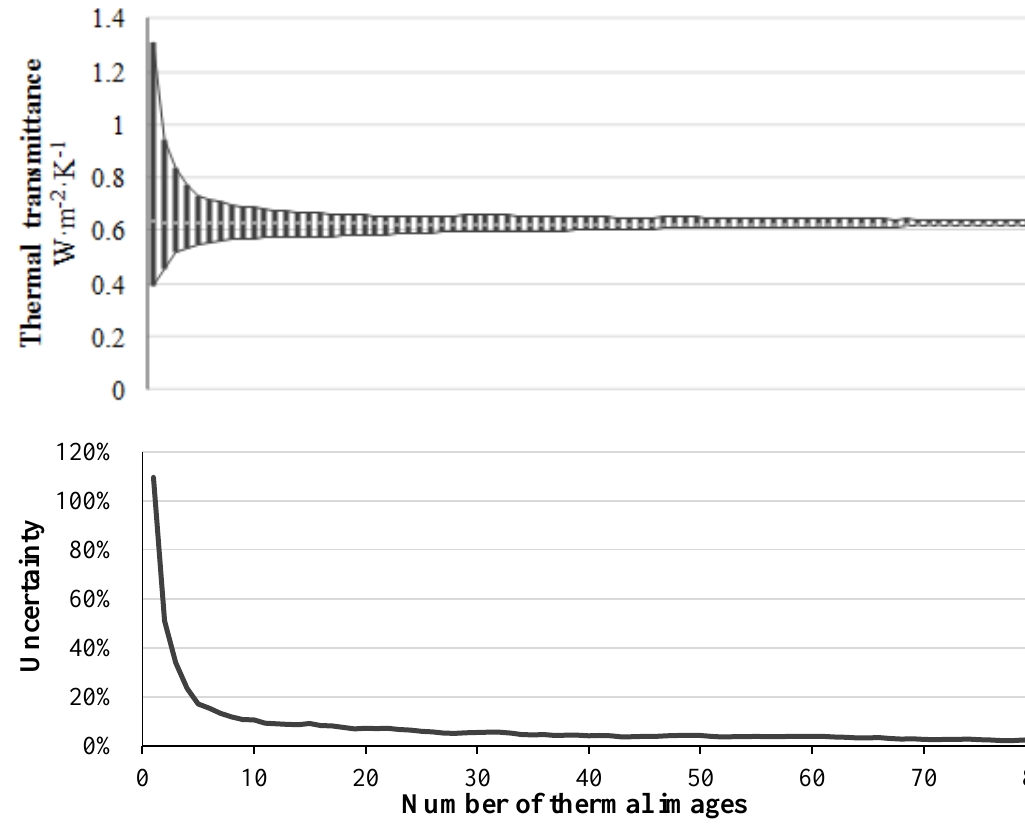
Figure 8. Summary of the main results: the thermal transmittance and the conductivity of the west, north and east walls. Uncertainties of the measurements are represented by the error bars.